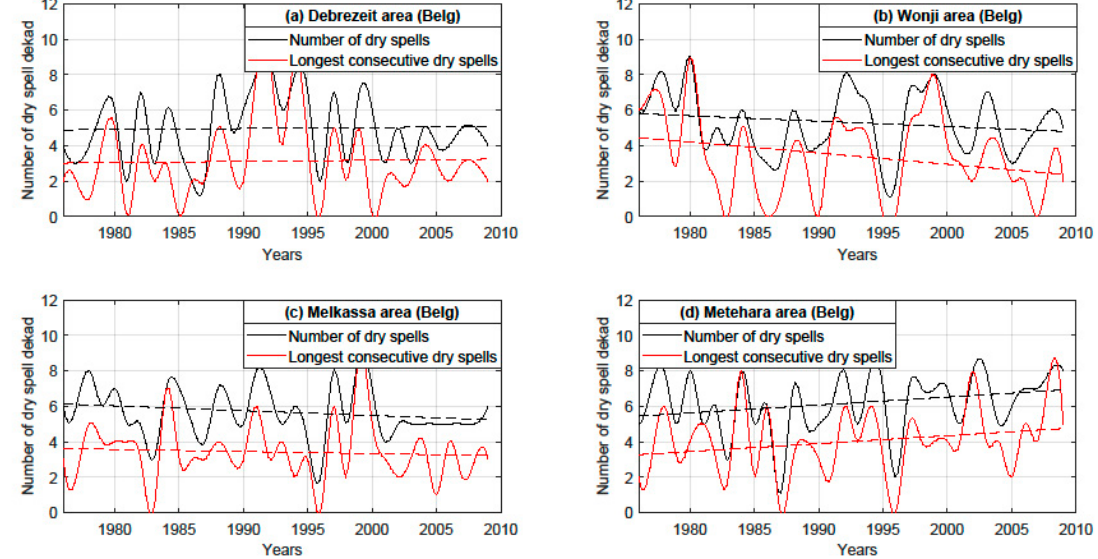
Figure 2. Temporal trends of dry spell patterns in the Belg season.